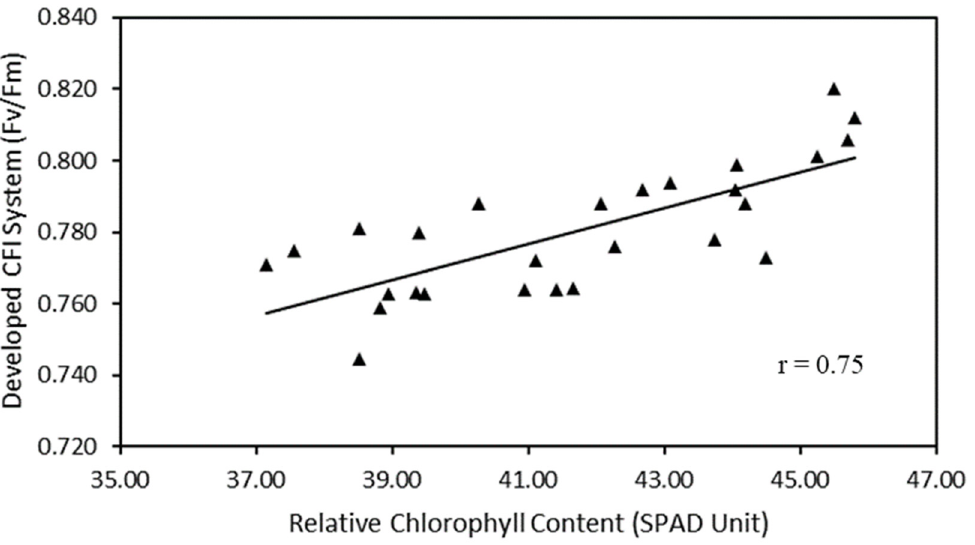
Figure 5. Scatter plots of relative chlorophyll content versus developed CFI system.